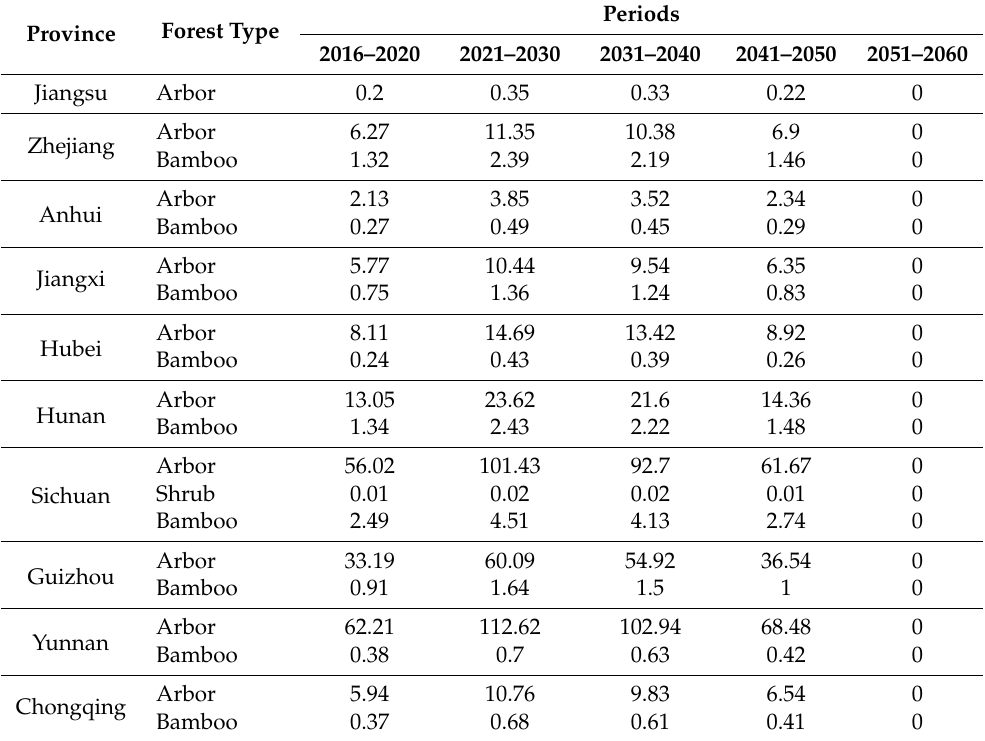
Table A3. Afforestation and reforestation area of forest from 2016 to 2060 in YREB (10 4 hm 2 ).